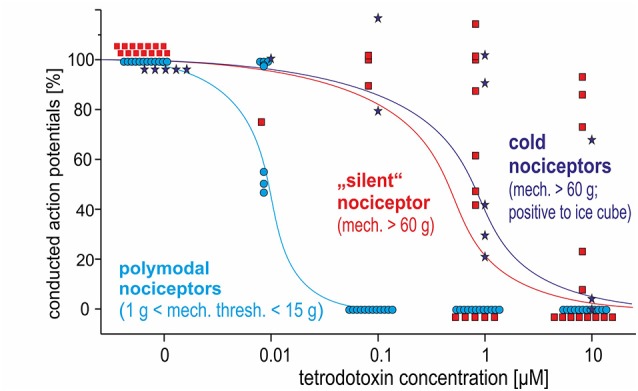
Dose-response curves for TTX-induced block of action potential generation and conduction in three different classes of C-nociceptors in pig, in vivo: polymodal (light blue), mechano-insensitive (“silent,” red) and cold nociceptors (dark blue stars). While all polymodal nociceptors are blocked following intracutaneous injection of TTX at 100 nM, silent nociceptors and cold nociceptors still conduct even after TTX-injections at 1 μM.